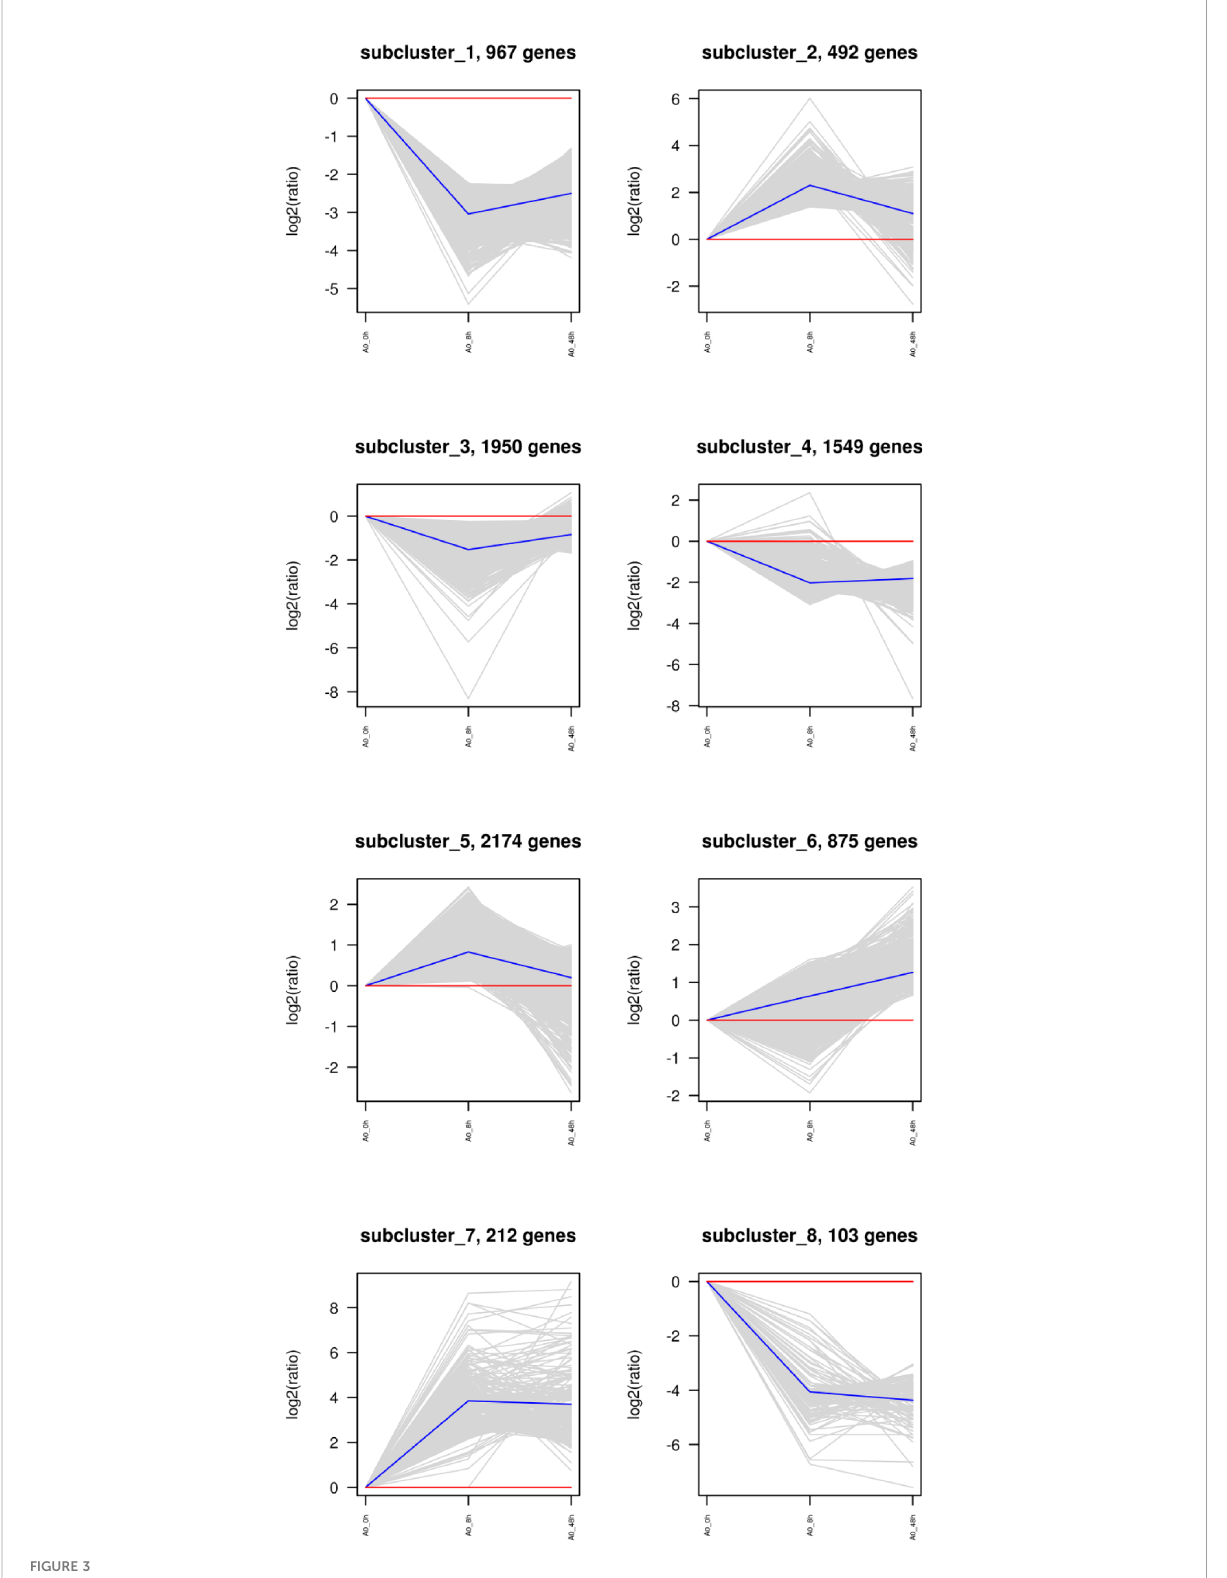
FIGURE 3 Cluster analysis of all differentially expressed genes (DEGs) between challenged groups (8 h and 48 h) and control group (0